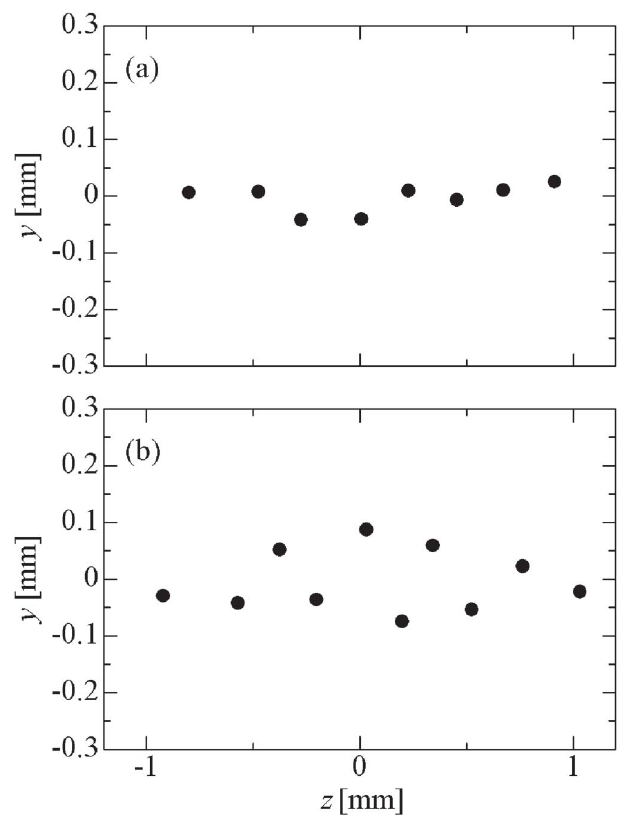
FIG. 14. Real-space configurations (side view) of laser-cooled beams at ultralow intensity. The total number of stored ions is 800 in case (a) and 1000 in case (b). Both beams execute a head- tail oscillation about the reference orbit on the horizontal plane. The individual ions do not pass each other